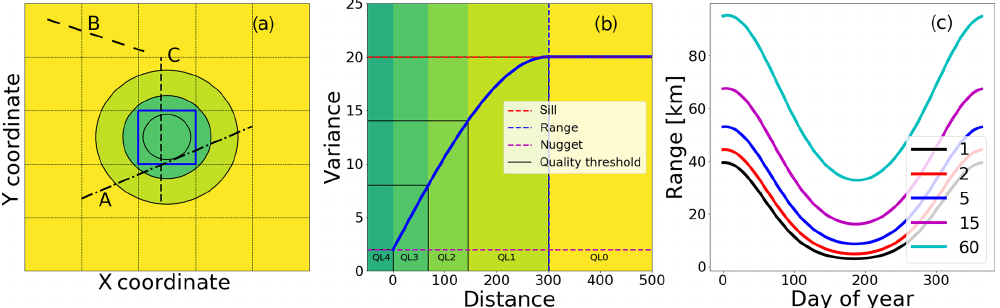
Figure 1. (a) Distribution of three links (thick black lines) compared to a grid cell under consideration (blue square). Link C is closest to the cell centre, and link A is within the grid cell. Link B is too far from the centre of the current grid cell to be considered. (b) Quality levels based on a spherical variogram. Here the highest quality (QL = 4) is dark green at zero distance, and no quality (QL = 0) is yellow, beyond the variogram range. The division in quality levels 1–3 is based on dividing the sill-to-nugget interval in three equal sections and then finding the corresponding distances. Colouring of the areas is the same for (a) and (b) . (c) Change of the range parameter of a spherical variogram throughout the year for accumulation times of 1, 2, 5, 15 and 60min for rainfall in the Netherlands (van de Beek et al., 2012).